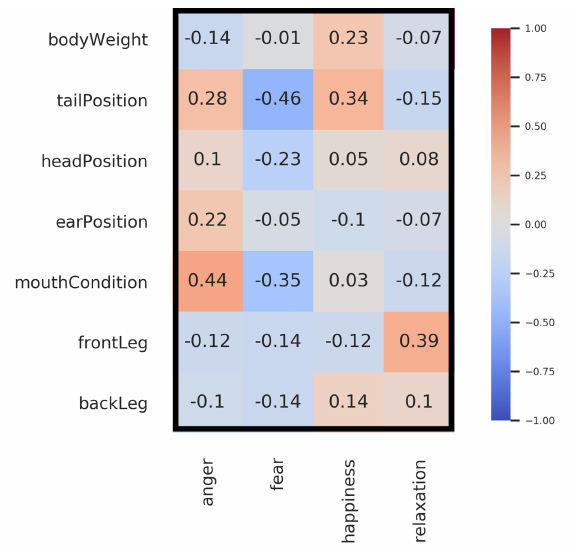
Figure 11. Correlation matrix for pose